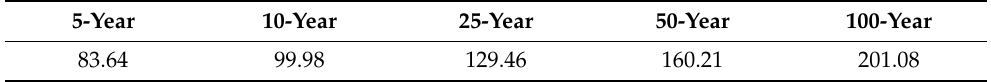
Table 4. Reference values of the total volume (mm) of the 24-h design storms.